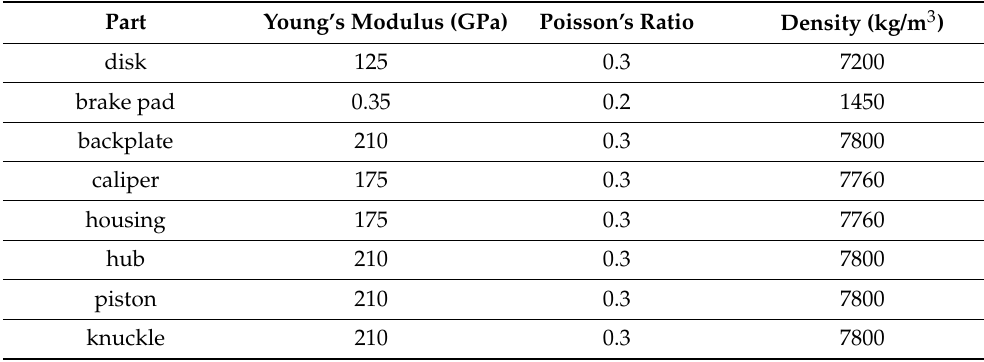
Table 1. Finite element model of the brake